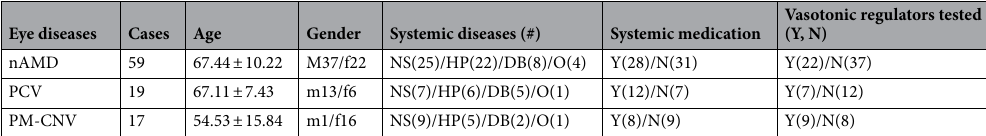
Table 1. Demographic and clinical features of the patients. nAMD neovascular age-related macular degeneration, PCV polypoidal choroidal vasculopathy, PM-CNV pathologic myopic choroidal neovascularization, DB diabetes, HP high blood pressure, NS no identified systemic disease, O others (lipidemia, Parkinson’s disease, and